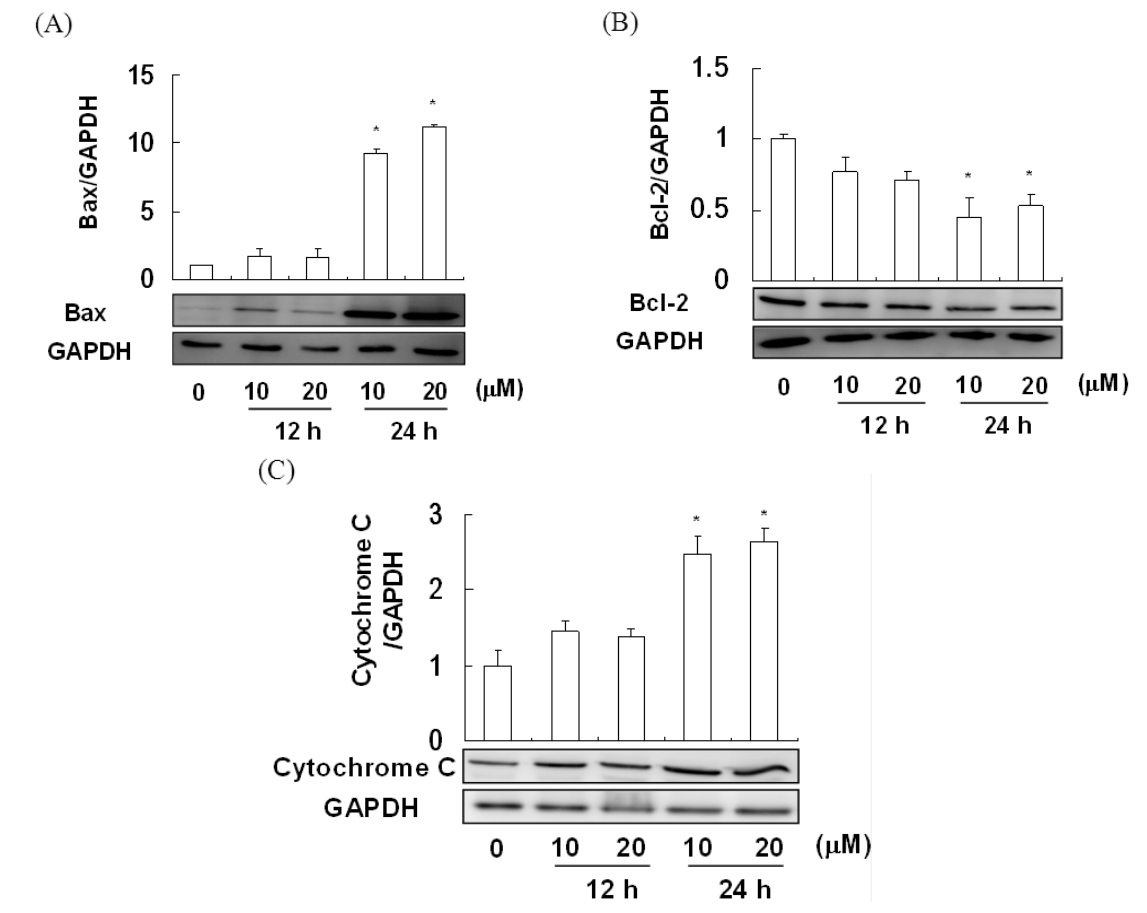
Figure 5. Bax and Bcl-2 expression of A549 cells treating with davallic acid at various concentrations for 12 h and 24 h, respectively. ( A ) Bax expression; ( B ) Bcl-2